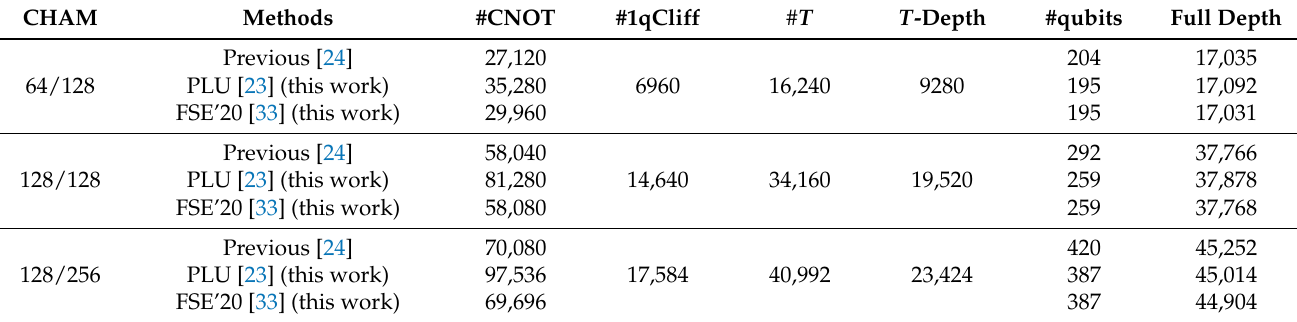
Table 4. CHAM quantum resources comparison by methods applied to key-schedule in